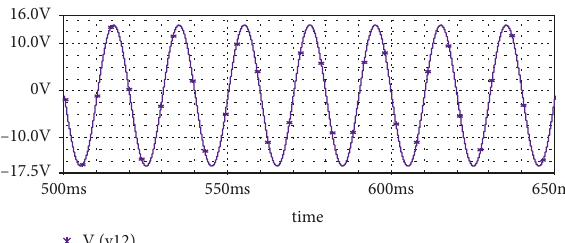
Figure 18: Sinusoidal waveform of the load torque driven by the PMSM. A � 15V, F � 50 Hz.